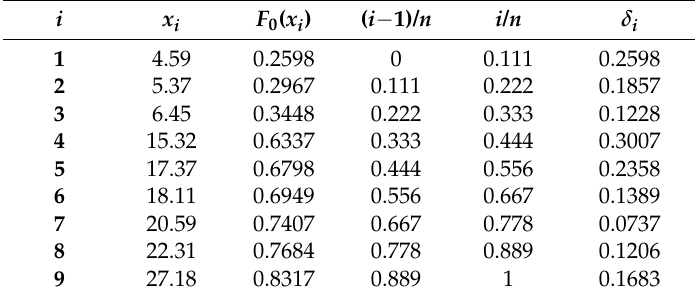
Table 5. Kolmogorov-Smirnov (KS) test of Gaussian